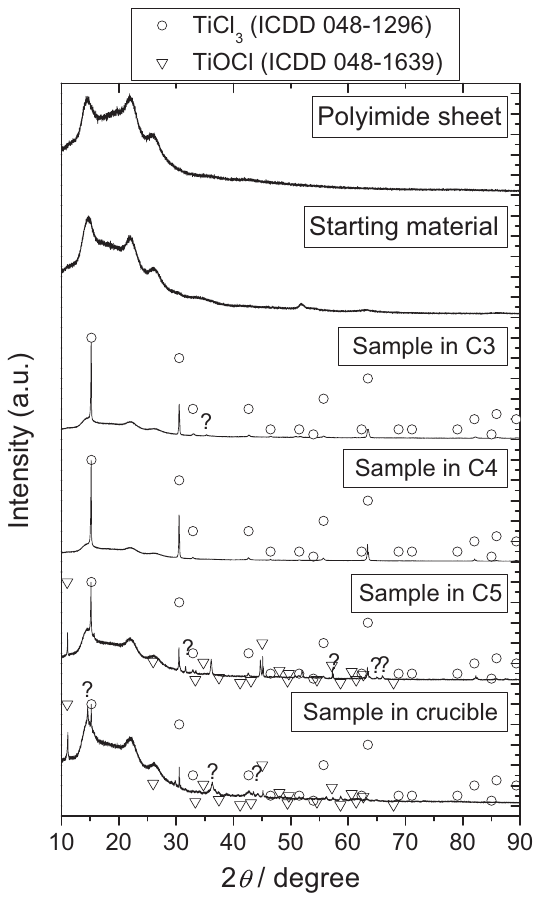
Figure 5. X-ray diffraction patterns of the condensed mate- rials in the collectors and the crucible.